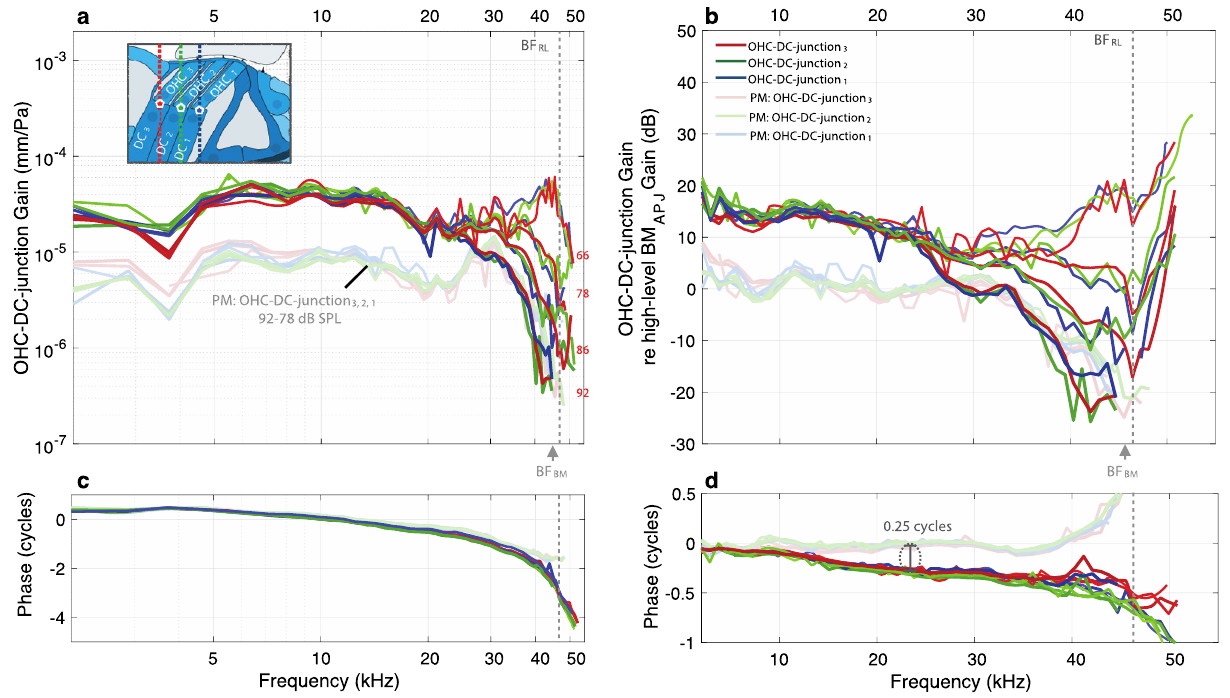
Figure 6. Motion comparisons of the OHC-DC junctions at the bottom ends of the OHCs, across the three OHC rows (OHC-DC-junction 3, 2, 1 ), for specimen G637. ( a ) In vivo (darker colors) and PM (faded colors) OHC-DC-junction 3, 2, 1 gains relative to the sound pressure (in units of mm/Pa). ( b ) The gains in ( a ) normalized by the high-level (92 dB SPL) BM APJ gain (in dB). The inset drawing in panel ( a ) shows the OCT-vibrometry measurement locations for OHC-DC-junction 3 (red pentagon), OHC-DC-junction 2 (green pentagon), and OHC-DC-junction 1 (blue pentagon). Each colored vertical line indicates the lateral position and direction of the OCT A-scans. ( c , d ) The phase responses corresponding to panels ( a , b ). The frequency axes are on a log scale in the first column and on a linear scale in the second column.